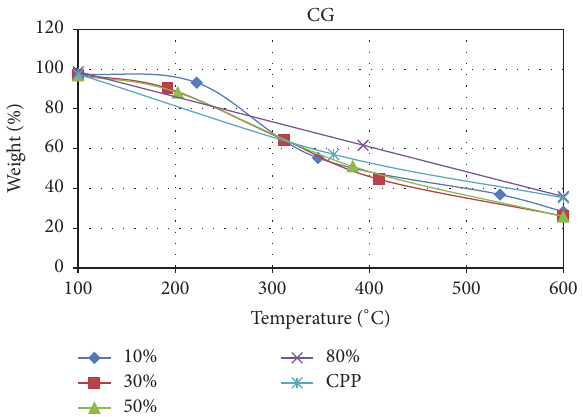
Figure 8: TGA results for all PUF samples with crude glycerol.